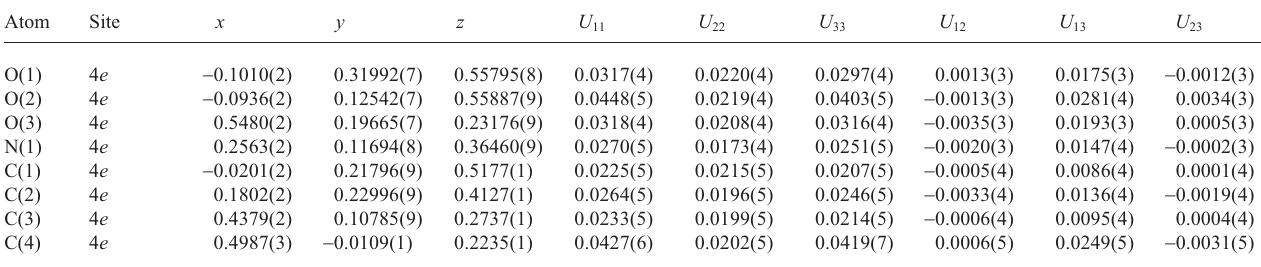
Table 3. Atomic coordinates and displacement parameters (in Å 2 )